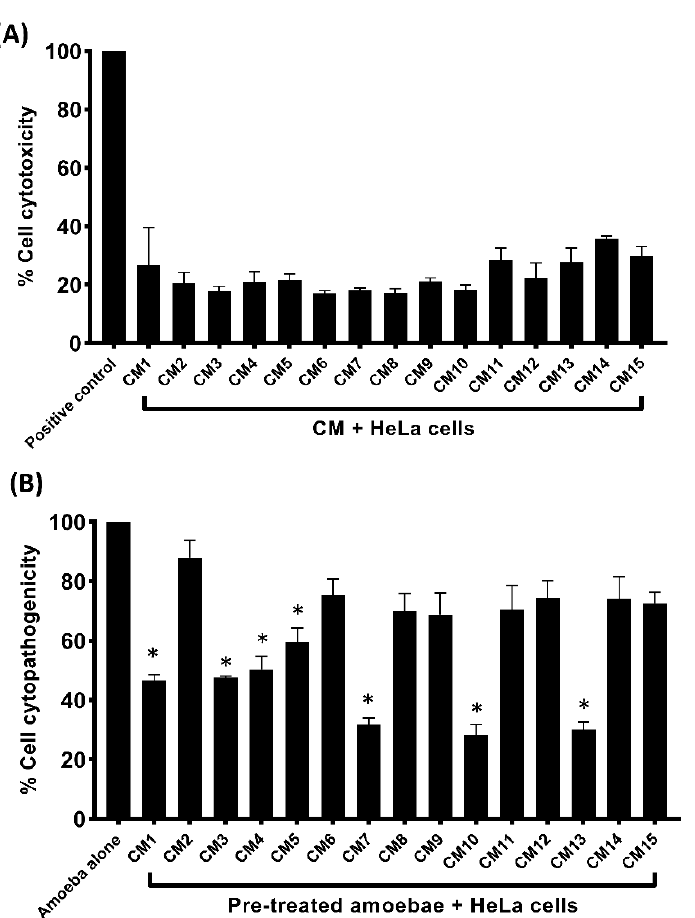
Figure 4. ( A ) The effects of CM on human cell lines. The compounds alone and in complex form exhibited limited cytotoxicity. ( B ) The cytopathogenicity of human cells was decreased by pre-treating A. castellanii with CM. The results revealed substantial inhibition of amoeba-mediated host cytotoxicity when compared to amoeba (untreated). Data are presented as mean ± standard error. (*) denotes where P ≤ 0.05.